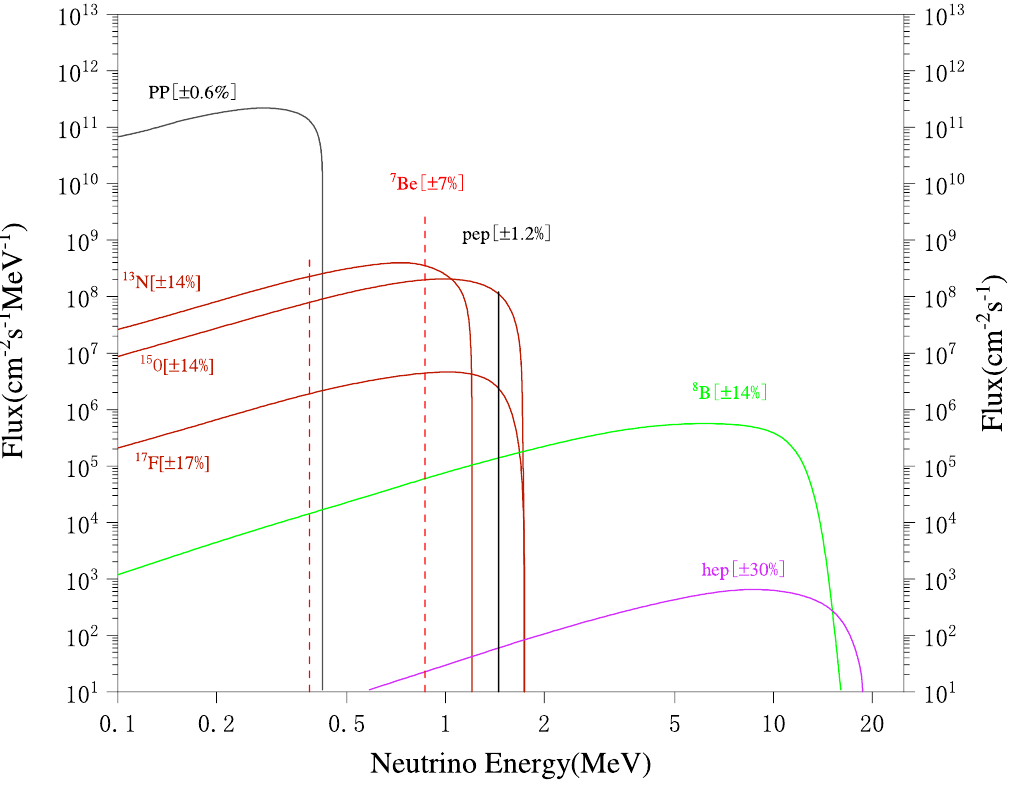
Figure 7 . Flux spectrum of solar neutrinos. This figure gives the flux spectra in earth surface for electron neutrino ν associated with different channels. The horizontal axis gives the energy of e neutrino in unit of MeV. The 7 Be neutrinos and pep neutrinos have discrete spectra, the unit in vertical axis is cm − 2 s − 1 . The pp , hep , 8 B, 13 N, 15 O, 17 F channels give rise to continuous spectra, and the unit in vertical axis is cm − 2 s − 1 MeV − 1 . In this figure, the solar neutrino flux spectrum is plotted based on the results in references [128,